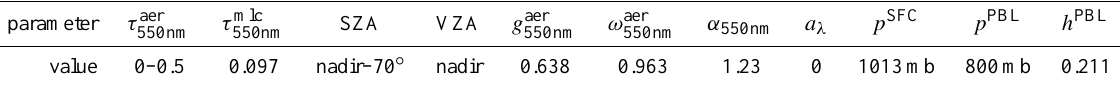
Table 2. Summary of the input parameters used in SMART and 6S for the accuracy assessment, with the aerosol and molecular optical depth τ aer and τ mlc , the solar and viewing zenith angle SZA and VZA, the aerosol asymmetry factor and single scattering albedo g aer 550nm 550nm and ω aer , the ˚Angstr¨om parameter α 550nm , the surface albedo a λ , as well as the air pressure at the surface and the planetary boundary 550nm layer p SFC and p PBL and the corresponding scaling factor h PBL